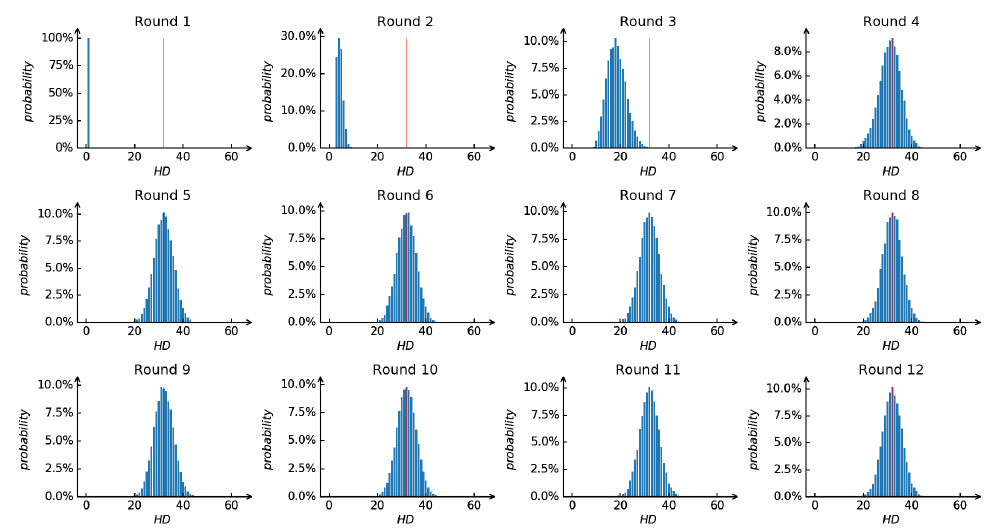
Figure 4. The diffusion of difference by the attack method with 4-bit changed (using 200,000 sets of data).